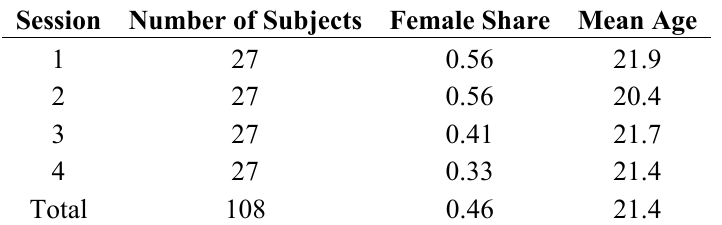
Table 1. Descriptive statistics of subjects by session: number of subjects, female share and mean